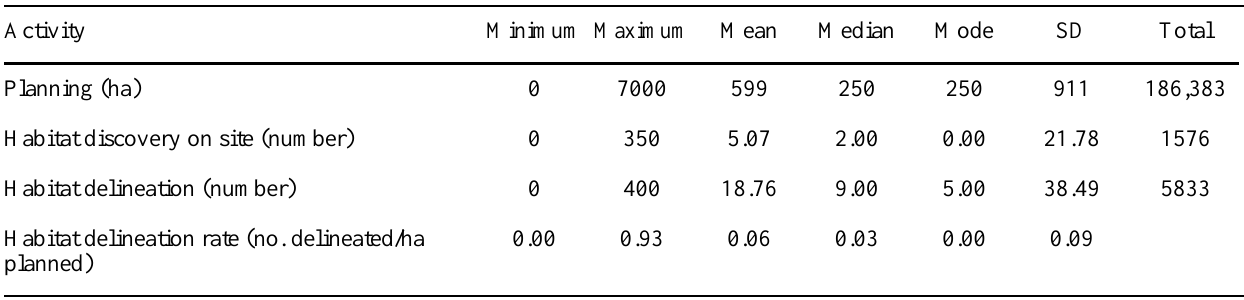
Table 2 . Planning, habitat discovery, and habitat delineation in 2005 ( N = 311).